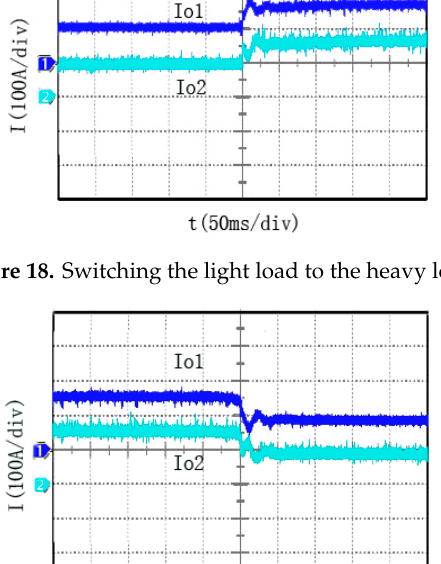
Figure 19. Switching the heavy load to the light load.